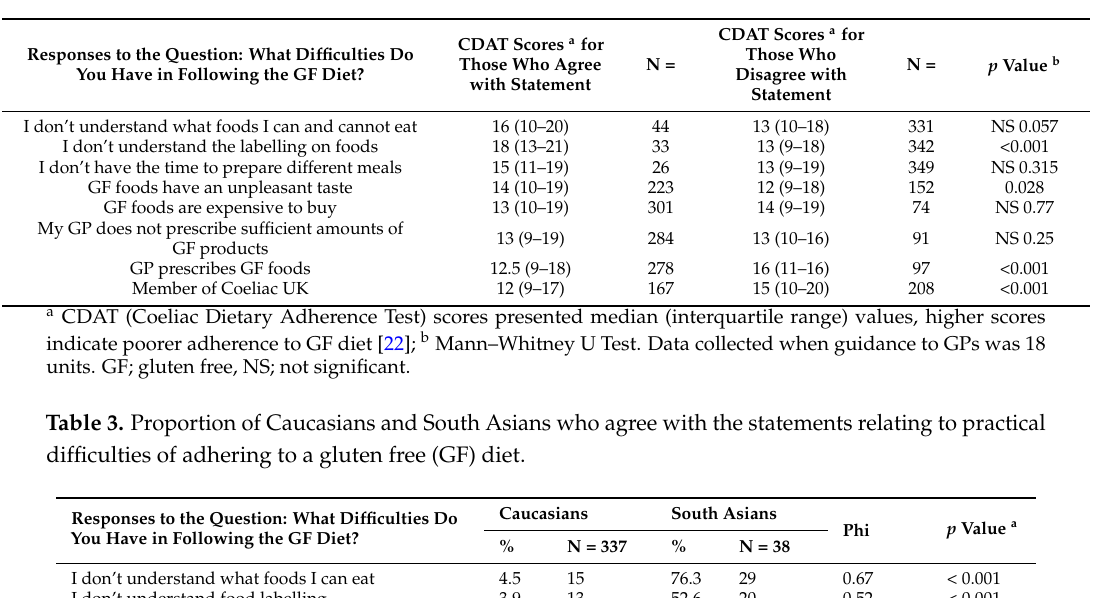
Table 2. Adherence to the gluten free diet, CDAT scores a presented related to responses to statements relating to practical difficulties of adhering to a gluten free (GF) diet.